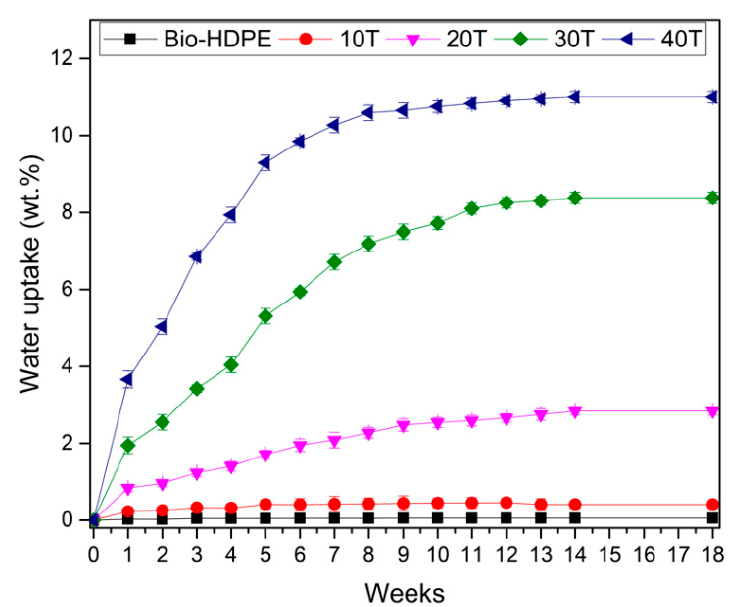
Figure 11. Water uptake of bio-based high-density polyethylene (Bio-HDPE) with different weight percentage of treated chia seed flour with APS.